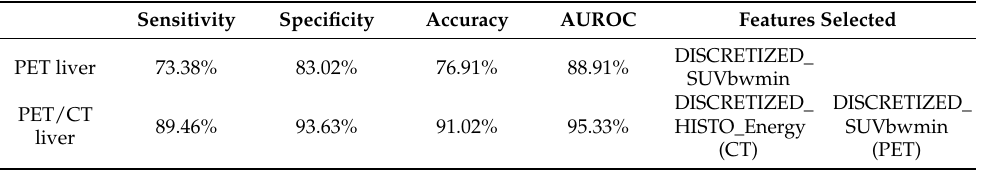
Figure 4. ROCs for the radiomics models implemented for discrimination of liver metastasis using PET and PET/CT images with an AUROC of 88.91% and 95.33%, respectively. Table 4. Radiomics features performance for liver metastasis discrimination. Table 4. Radiomics features performance for liver metastasis